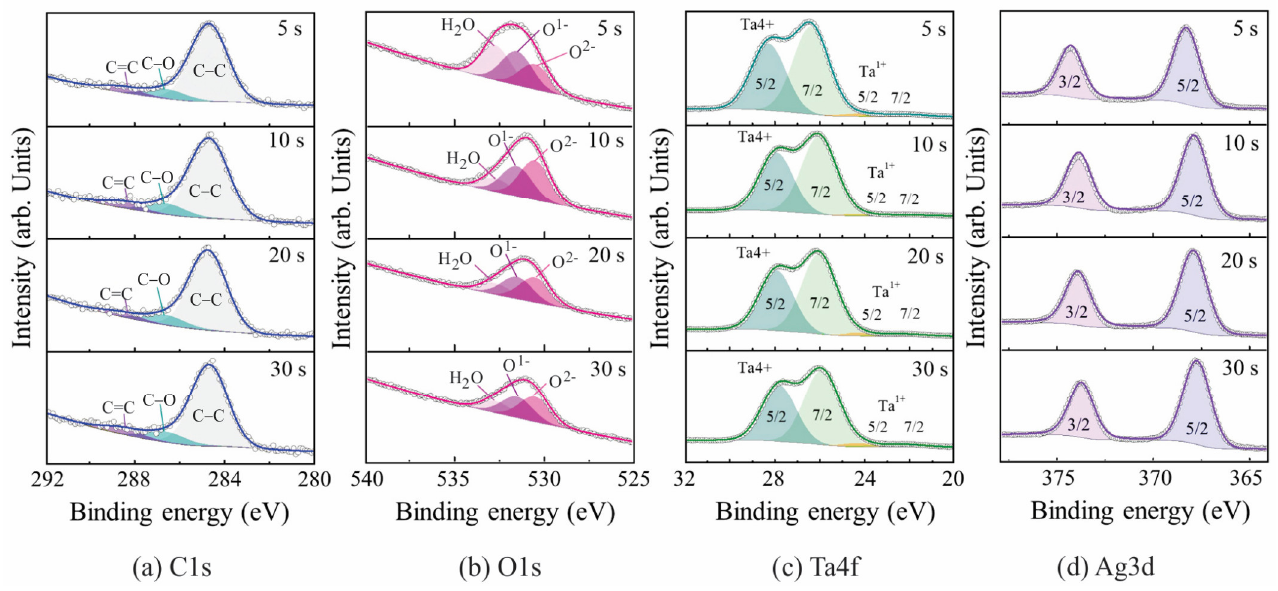
Figure 6. XPS deconvoluted spectra.